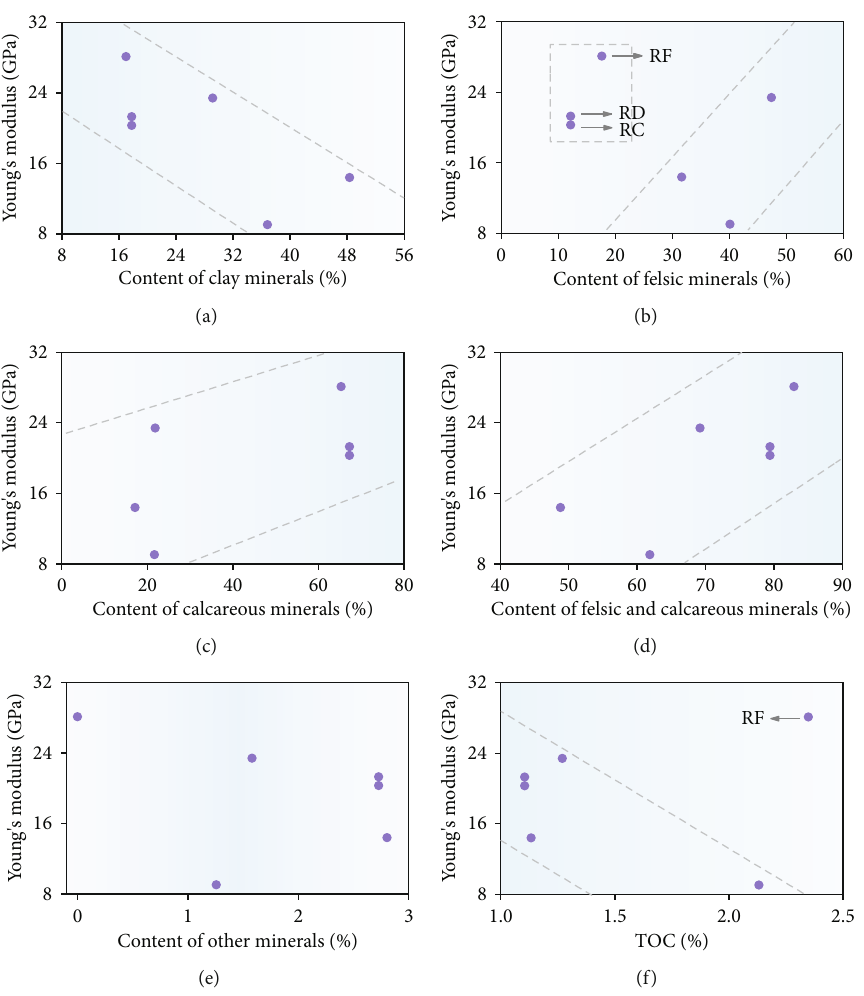
Figure 10: Relationship of Young ’ s modulus of mudstone and shale with (a) clay, (b) felsic, (c) calcareous, (d) felsic and calcareous minerals, (e) other minerals, and (f)